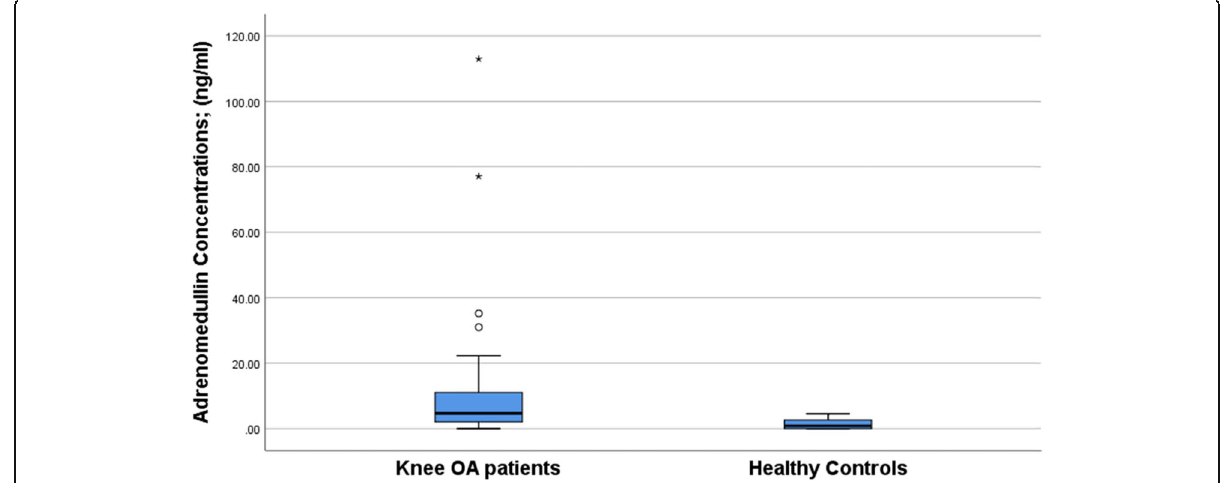
Fig. 2 Serum Adrenomedullin concentrations in the case and control group